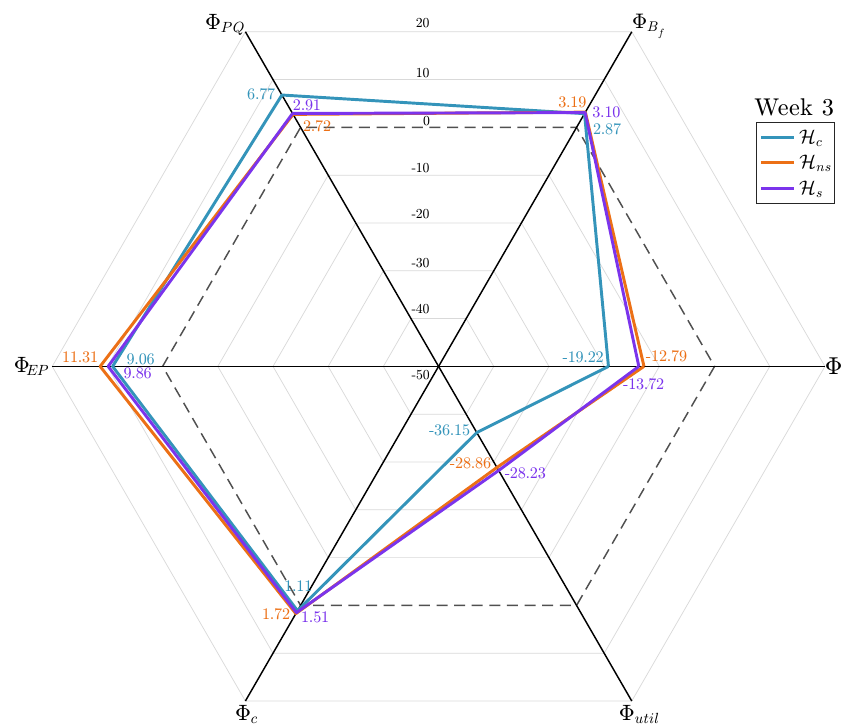
Figure 6. Energy operation economic result for Week 2.